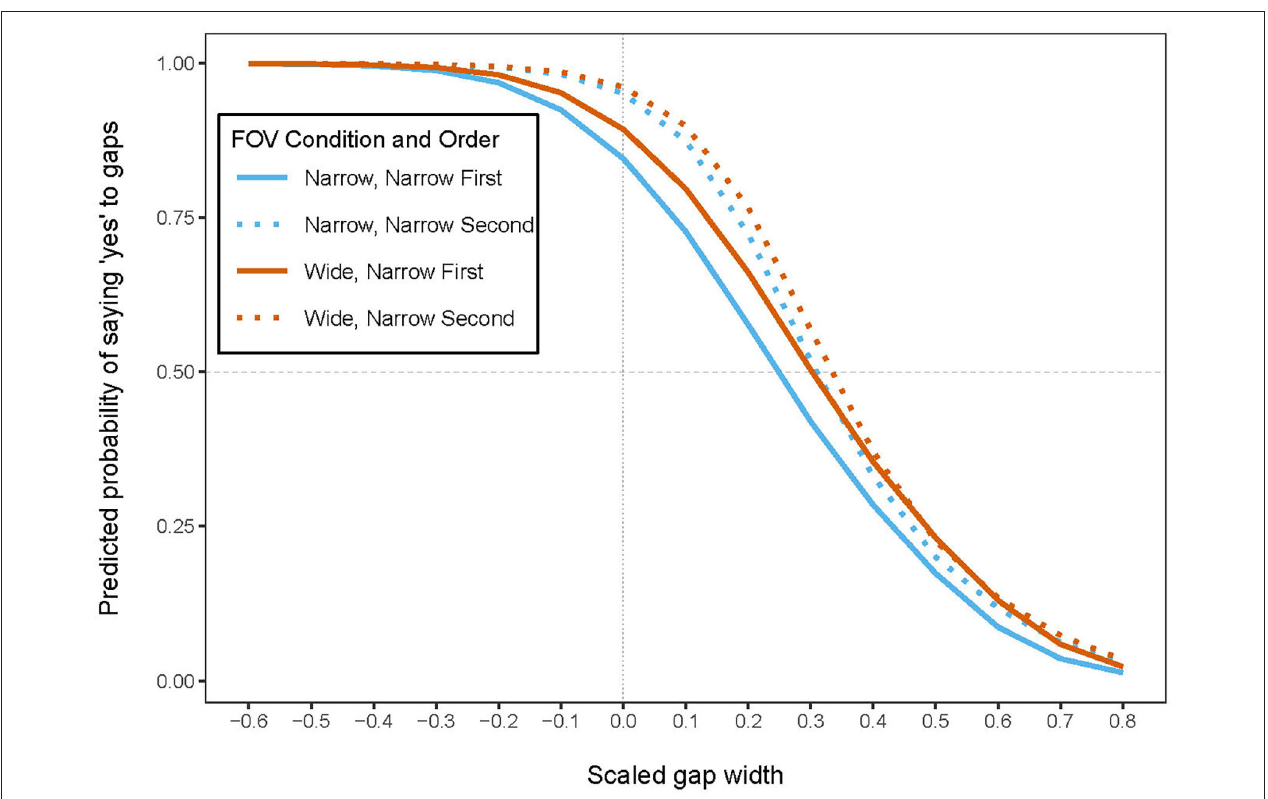
FIGURE 8 | Experiment 3 results. Predicted probability of saying “yes” to gap crossing as a function of scaled gap width for the Narrow FOV condition (blue lines) and Wide FOV condition (orange lines) at two condition orders [Narrow FOV experienced first (solid lines) and Narrow FOV experienced second (dotted lines)]. The dotted line at x = 0.0 indicates when gap width = actual step length. The point of subjective equality (PSE) is the value of scaled gap width (on the x-axis) at which the curve intersects with y =